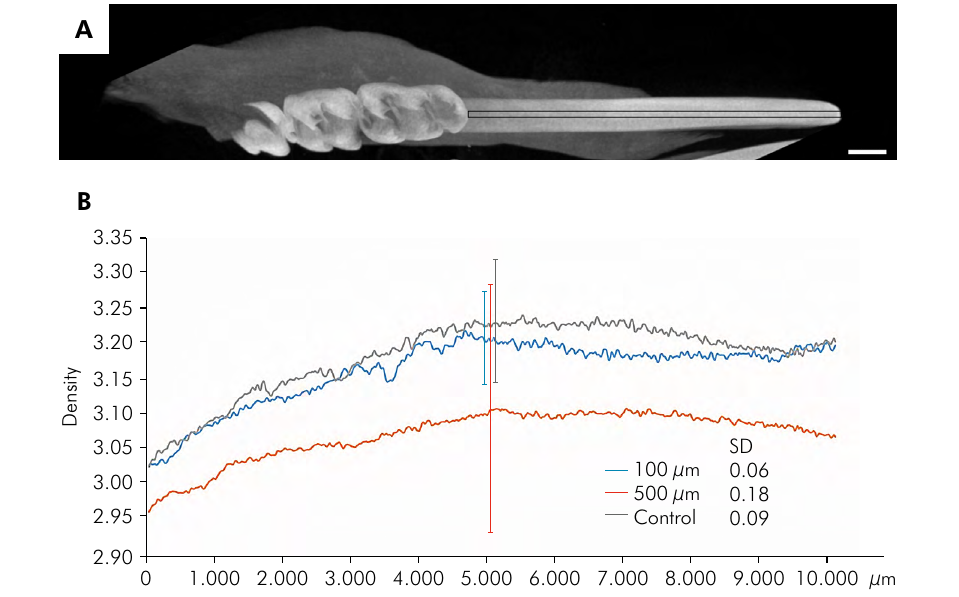
Figure 1. A. ImageJ projection of a half mandible and right side incisor from a rat given 100 mg/kg amoxicillin. Inserted the area from which the density was measured. bar: 10 000 µm, white dashed line represents the area used to calculate the SD reported in Figure 1B. B. Scatter plot of mean enamel density values from five incisors/experiment. The measurement was made from the mesial surface of the first molar towards the tip of the incisor. The SD was measured at 5000 µm from the molar mesial surface, approximately at the point where the incisor enamel has reached full mineralization (dashed line in A).